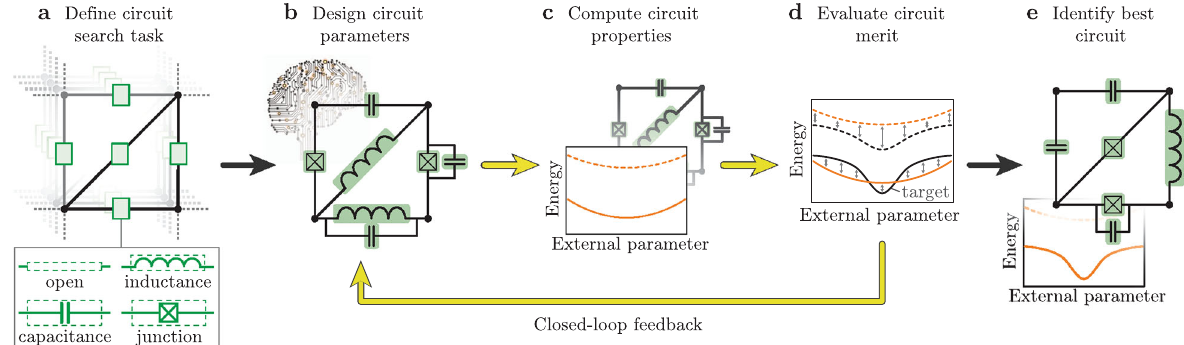
Fig. 1 Implementation of SCILLA, enabling automated circuit design. a De fi nition of the circuit design task, for which details about the general circuit architecture, parameter bounds, and design targets are provided. b Based on the general architecture, the design module evokes parameter generating algorithms to place components and choose component parameters in the circuit. c Calculation of circuit properties such as spectra or noise sensitivity. d Estimation of the agreement between computed properties and target properties. e Circuits that are close to the design target are identi fi ed. A database system facilitates asynchronous execution and parallelization of the work fl ow as well as re fi nement of design choices (closed-loop feedback) based on merit evaluations of previously proposed